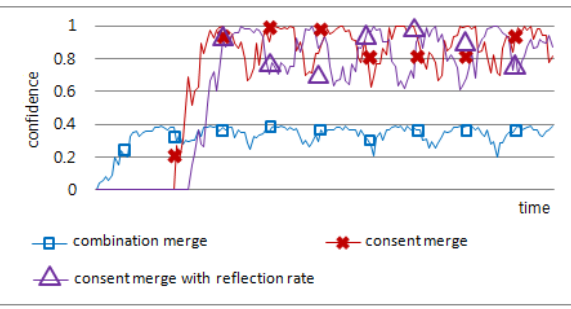
Fig. 4. The confidence weight computed by the agents.